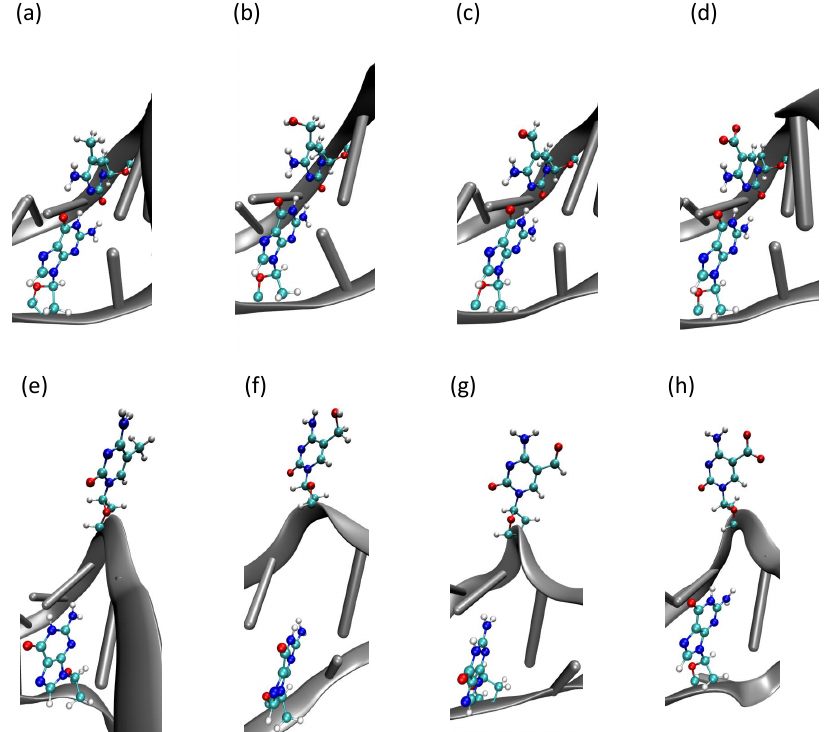
Figure 5. Snapshots of the DNA base flip simulation taken at about the free energy minimum of ( a ) 5-methyl-cytosine; ( b ) 5-hydroxymethyl-cytosine; ( c ) 5-formyl-cytosine; and ( d ) 5-carboxyl-cytosine; and snapshots of the DNA base flip simulation taken at about the free energy maximum of ( e ) 5-methyl-cytosine; ( f ) 5-hydroxymethyl-cytosine; ( g ) 5-formyl-cytosine; and ( h ) 5-carboxyl-cytosine. Colours refer to different atom types: red: oxygen; cyan: carbon; blue: nitrogen; white: